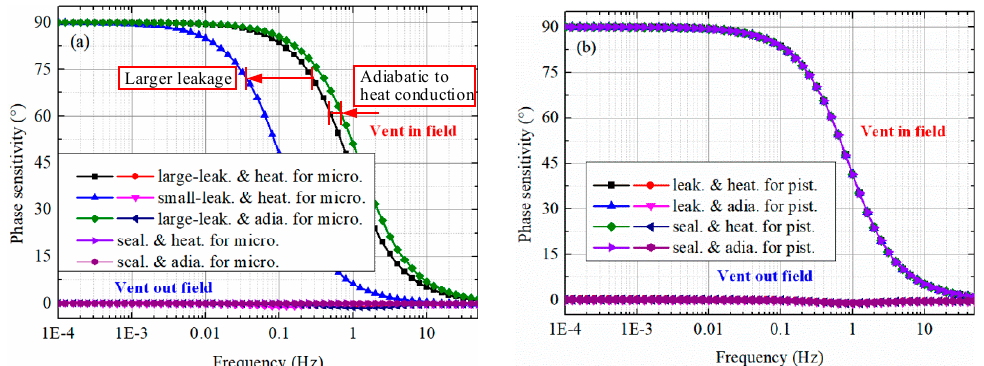
Figure 16. ( a ) Phase sensitivity of the microphone in two venting states, in which the properties of the microphone change. ( b ) Phase sensitivity of the microphone in two venting states, in which the properties of the pistonphone change.